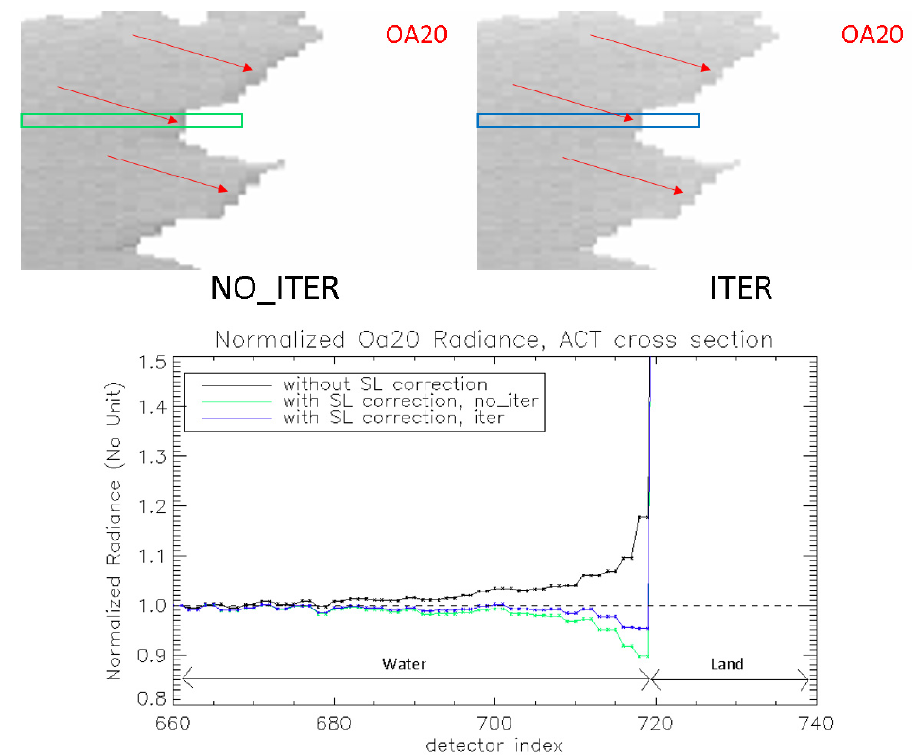
Figure 6. Earth Observation stray-light corrected Oa20 radiance over part of the lake of Michigan where dark / bright (water / land) transition occurs (OLCI-A scene, 27 / 07 / 2017 15h35), ( upper left ) without iteration, ( upper right ) with iterations. The red arrows highlight some improvements brought by the iterative method. ( bottom ) ACT cross-section in the region of the image indicated by the rectangle (a few frames were averaged to reduce the noise). The curves were normalized by their radiance value at detector index 660 located in the water part at a significant distance from the water / land transition. The data without stray ‐ light correction has been added in black.